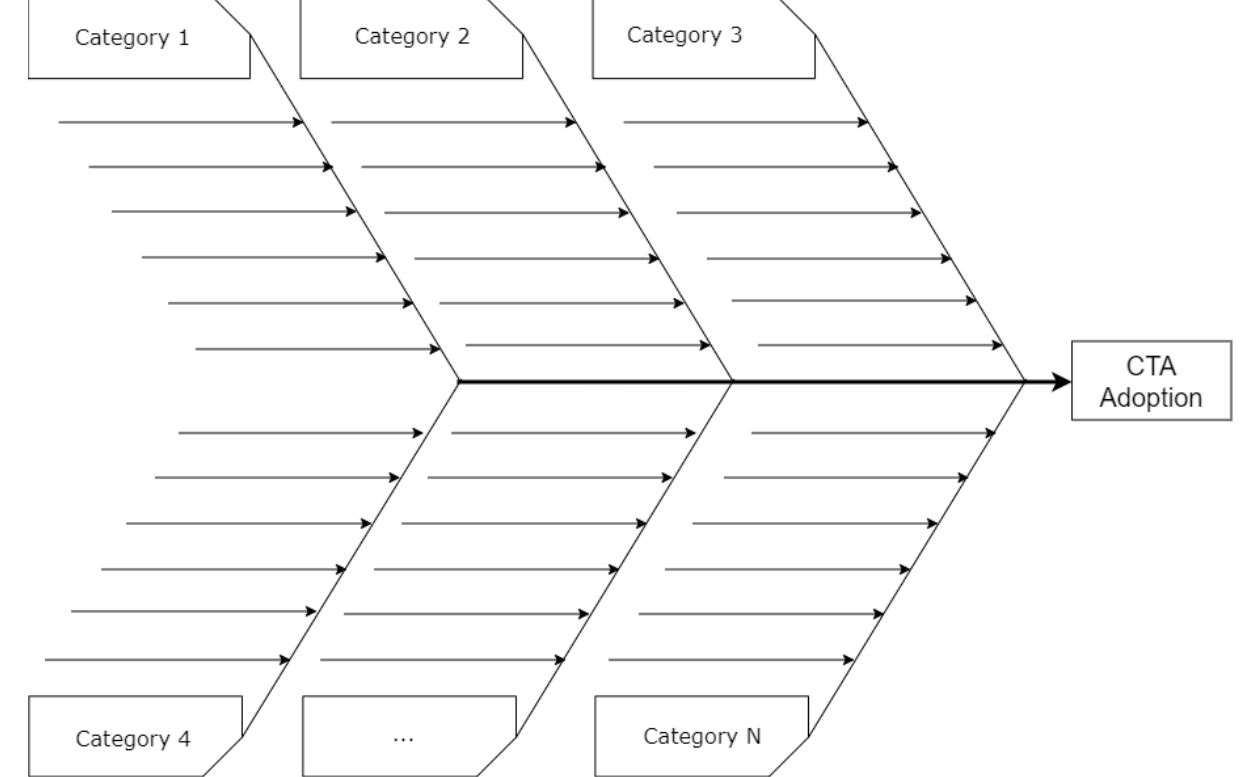
Figure 2. Preliminary fishbone diagram showing the factors that influence the adoption of contact tracing apps. Arrows represent facilitators and barriers. CTA: contact tracing app.